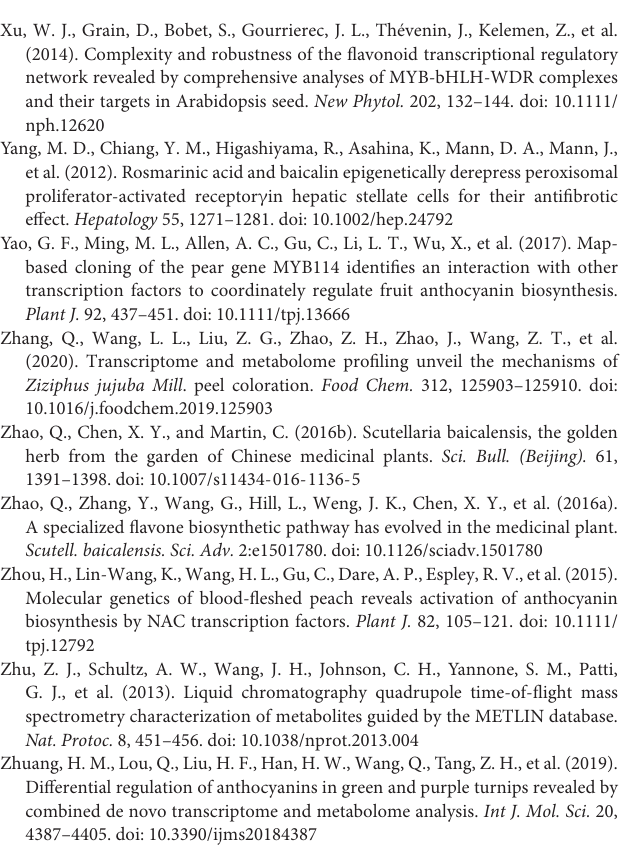
fig (Ficus carica L.) fruit color: Metabolomic and transcriptomic analyses of the flavonoid biosynthetic pathway. Front. Plant Sci. 8:1990. eCollection